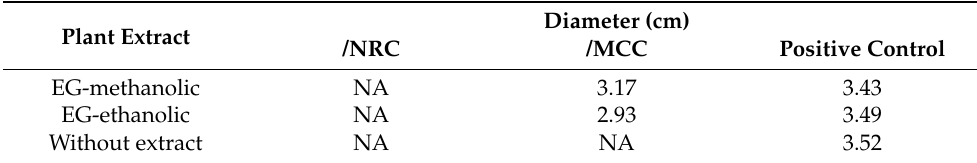
Without extract NA Legend: NA = non-active.